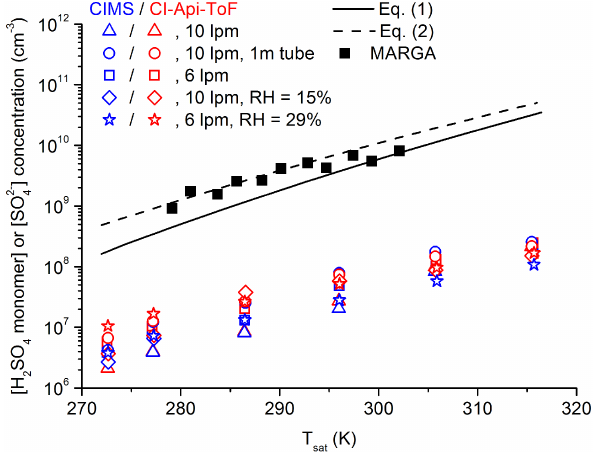
Figure 3. Measured sulfuric-acid monomer [H 2 SO 4 monomer] concentration and total-sulfate [SO 2 − ] (black squares) concentra- 4 tions together with predicted values by Eqs. (1) and (2) as a function of saturator temperature T sat . Saturator flow rate is Q sat = 0.5Lpm and mixing flow rates were 40Lpm (dry for CIMS and CI-Api-TOF and RH 15%) and 20Lpm (MARGA and RH 29%). CIMS (blue markers) and CI-Api-TOF (red markers) have been tested with 6 and 10Lpm (nominal) inlet total flow rates and also with an extra 1m Teflon tubing after